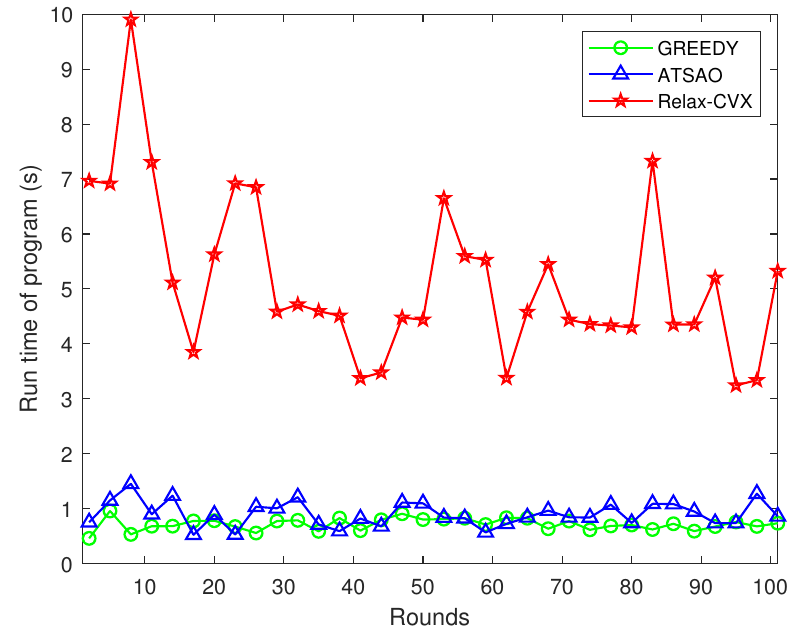
Figure 8. The time spent running each